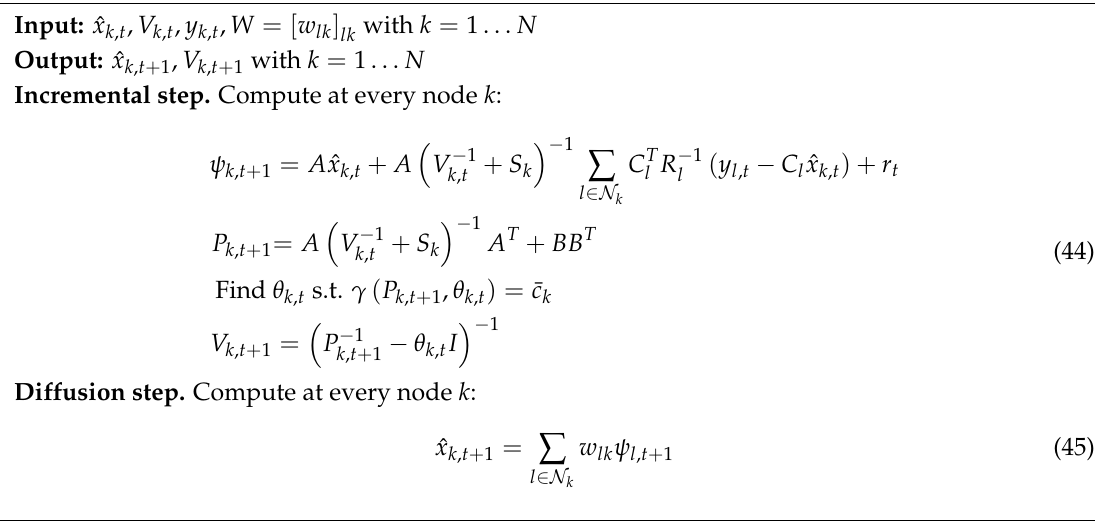
Algorithm 3 Efficient distributed robust Kalman filter with non-uniform local tolerance at time t